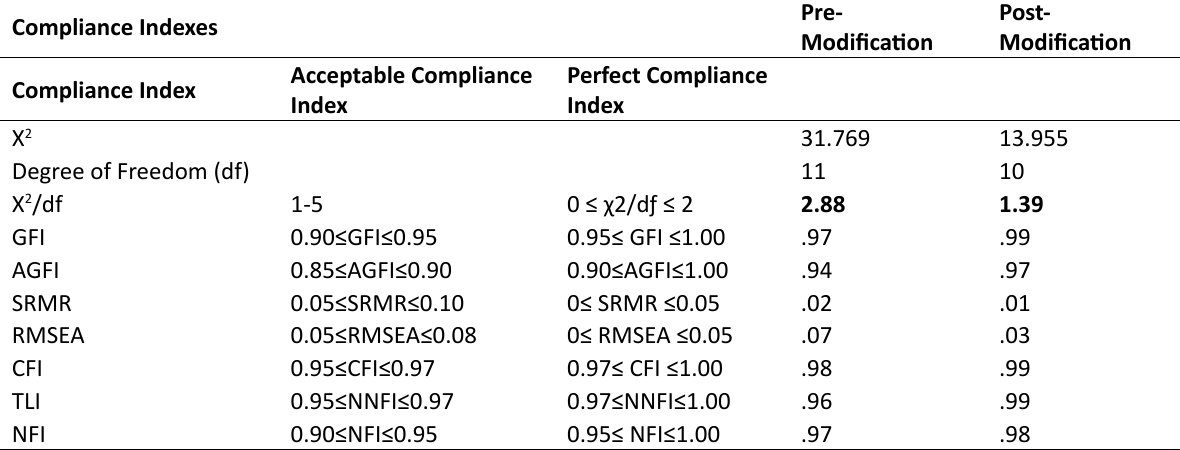
Table 3. Compliance values of the structural equality model